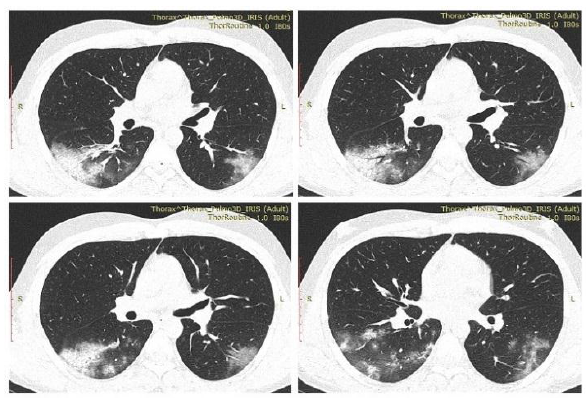
Figure 6 . CT image of patient 1, follow-up, progression